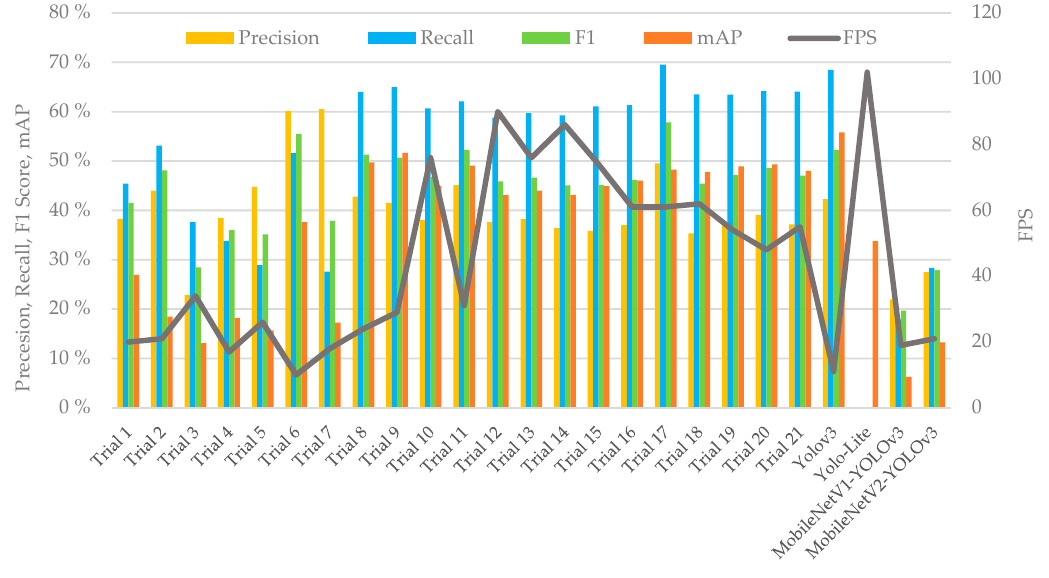
Figure 6. Comparison of the effects of different trials using the PASCAL VOC 2007 dataset during the construction of Mixed YOLO3-LITE.